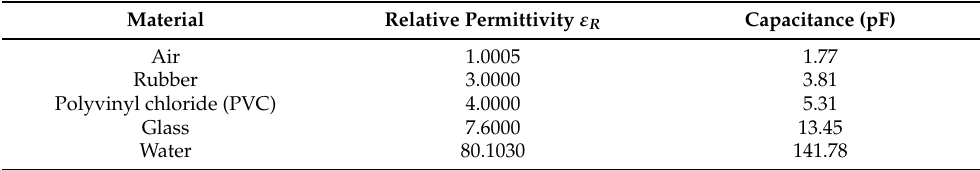
Table 3. Comparison of materials and their influence on the resulting capacity of the CPT system